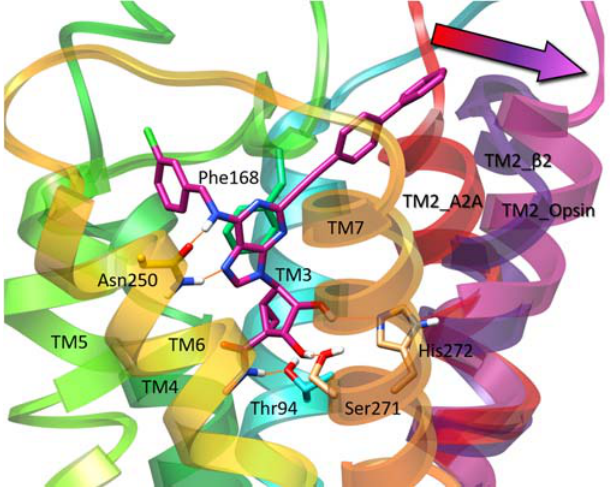
Figure 6. Docking pose of MRS5679 ( 12 , violet sticks) at the hA 3 AR model based on a hybrid A 2A AR ‐ opsin template where TM2 (violet ribbon) is shifted outward from the binding site with respect to the model based on the hybrid A 2A AR ‐β 2 template (purple ribbon) and the one based entirely on the human A 2A AR (red ribbon) [27]. H ‐ bond interactions are represented as orange solid lines and TM1 is omitted to aid visualization. The residue Ballesteros–Weinstein notation [32] is: Thr94 (3.36), Phe168 (EL2), Asn250 (6.55), His272 (7.43), Ser271 (7.42) and His272 (7.43).